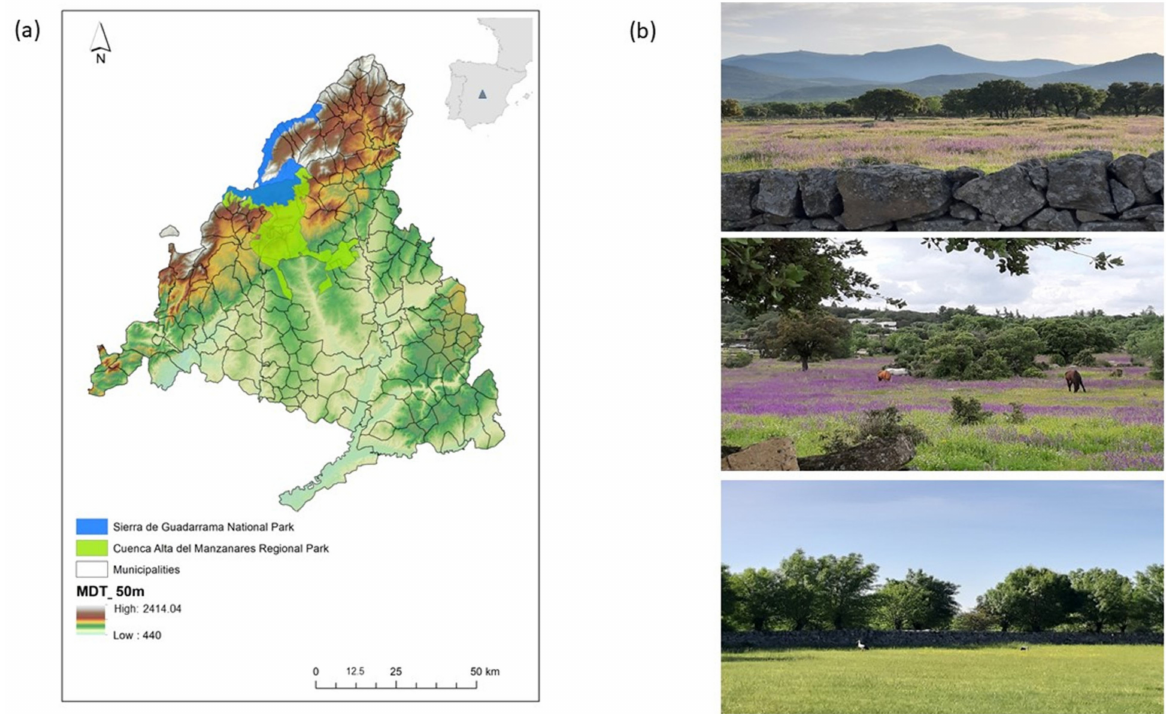
Figure 2. ( a ) Location of the study area in the Madrid region (central Spain). The two main categories of landscape protection at present (Regional Park and National Park) are shown, as well as the overlapping area between both parks; ( b ) HNVF characteristics of the study area (mainly silvopastoral